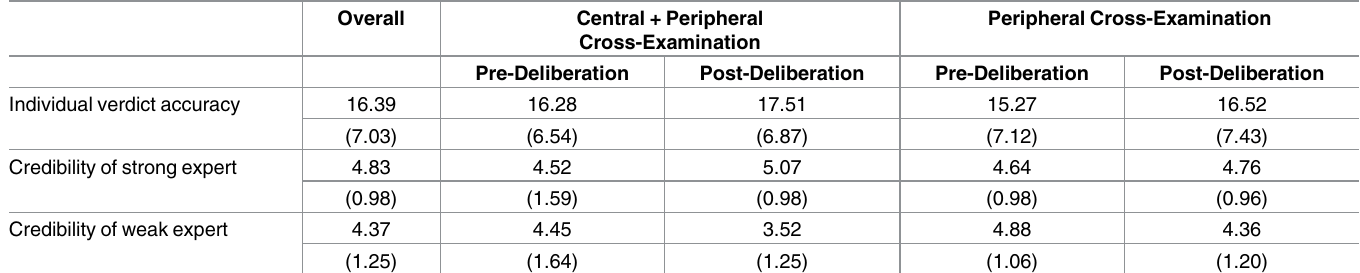
Individual participants were more confident in the accurate verdict when they heard a cross-examination that focused them on central (versus peripheral) information about the expert, B = 4.17, t (28) = 3.53, p = .002, 95% CI s = [1.85, 6.49]. This effect (and a significant